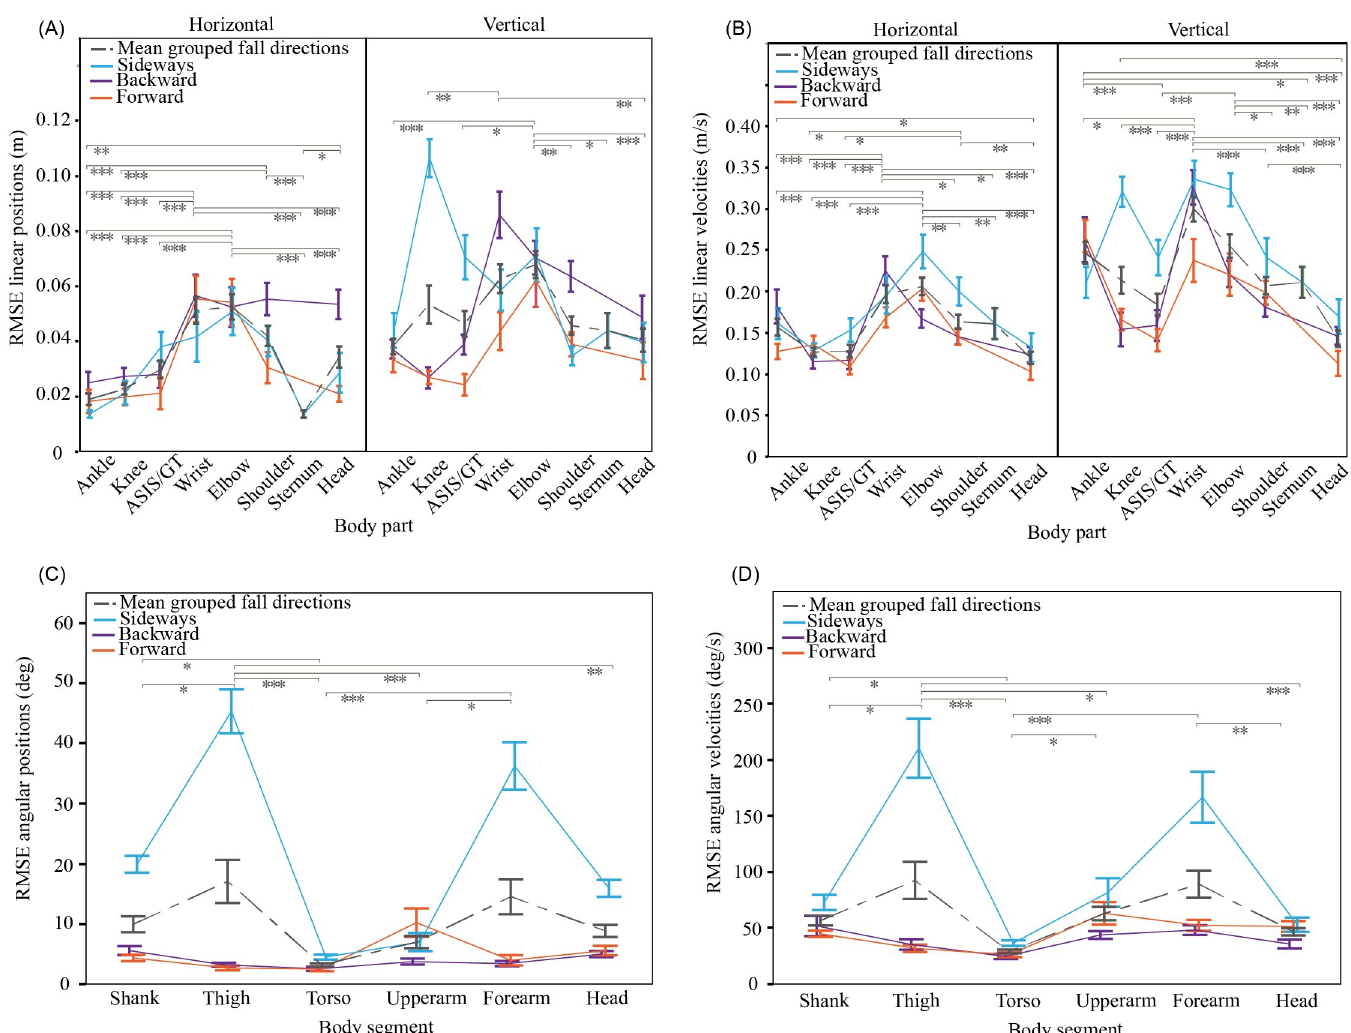
Fig 7. Differences across body sites and fall directions in the accuracy of Kinovea estimates. (A) Linear position, (B) linear velocity, (C) angular position, and (D) angular velocity. Root mean square errors (RMSE) are from comparison between Qualisys ground truth signals and Kinovea estimates based on the 90 deg camera angle, the calibration frame located in the plane of the fall, and filtering of position data with a 10 Hz cut-off frequency. Data points show mean values, and error bars show ± 1 SE (sideways = blue, backward = purple, forward = orange; grey = mean values across all fall directions). Significant differences are shown for mean values across all fall directions ( � p � 0.05, �� p � 0.01, ��� p �